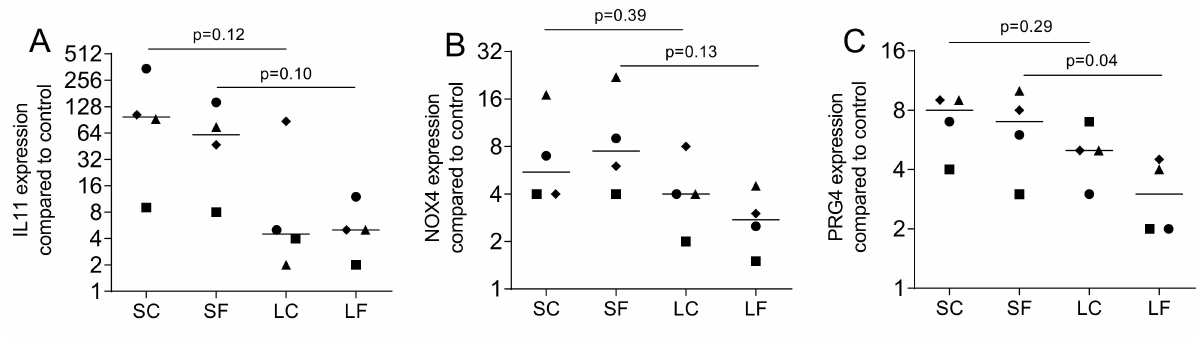
Figure 2. Gene expression of fibroblasts exposed to the supernatants and acid lysates of allografts. Gingival fibroblasts were exposed to aqueous supernatants of OraGRAFT ® Demineralized Cortical Particulate (SC) and OraGRAFT ® Prime (SF) and the acid lysates of the two respective allografts (LC and LF). The expression of ( A ) interleukin 11 (IL11), ( B ) NADPH oxidase 4 (NOX4), and ( C ) proteoglycan 4 (PRG4) was measured by quantitative RT-PCR. N = 4. Statistic is a paired t -test.